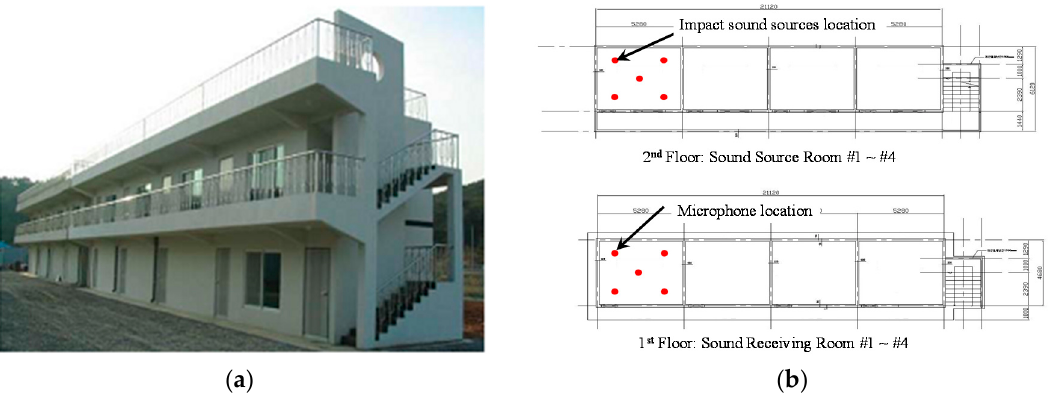
Figure 13. Overview and floor plan of the test building: ( a ) ISO view of the test building; and ( b ) floor plan of the test building.